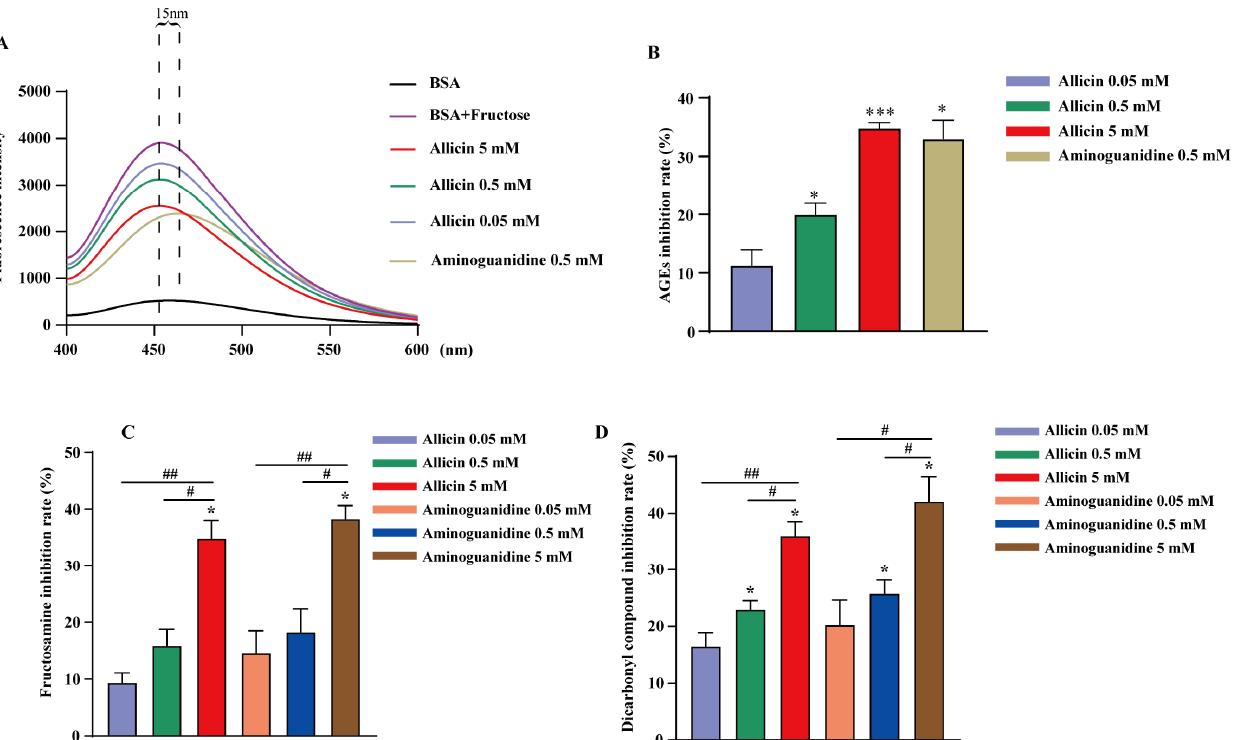
Figure 6. Inhibitory effects of allicin on the production of AGEs in vitro . Fluorescence intensity ( A ), AGE inhibition ( B ), inhibition of fructosamine ( C ), and inhibition of α -dicarbonyl compounds ( D ). The statistical significance of the outcomes was assessed by t -tests ( n = 4). “*” represents statistically significant inhibition of the production of fructosamine, α -dicarbonyl compounds, and fluorescent AGEs by different concentrations of the drug (* p < 0.05, *** p < 0.001). “#” represents a significant difference in the inhibition production of fructosamine, α -dicarbonyl compounds, and fluorescent AGEs between different concentrations of the same drug ( ## p < 0.01 , # p <